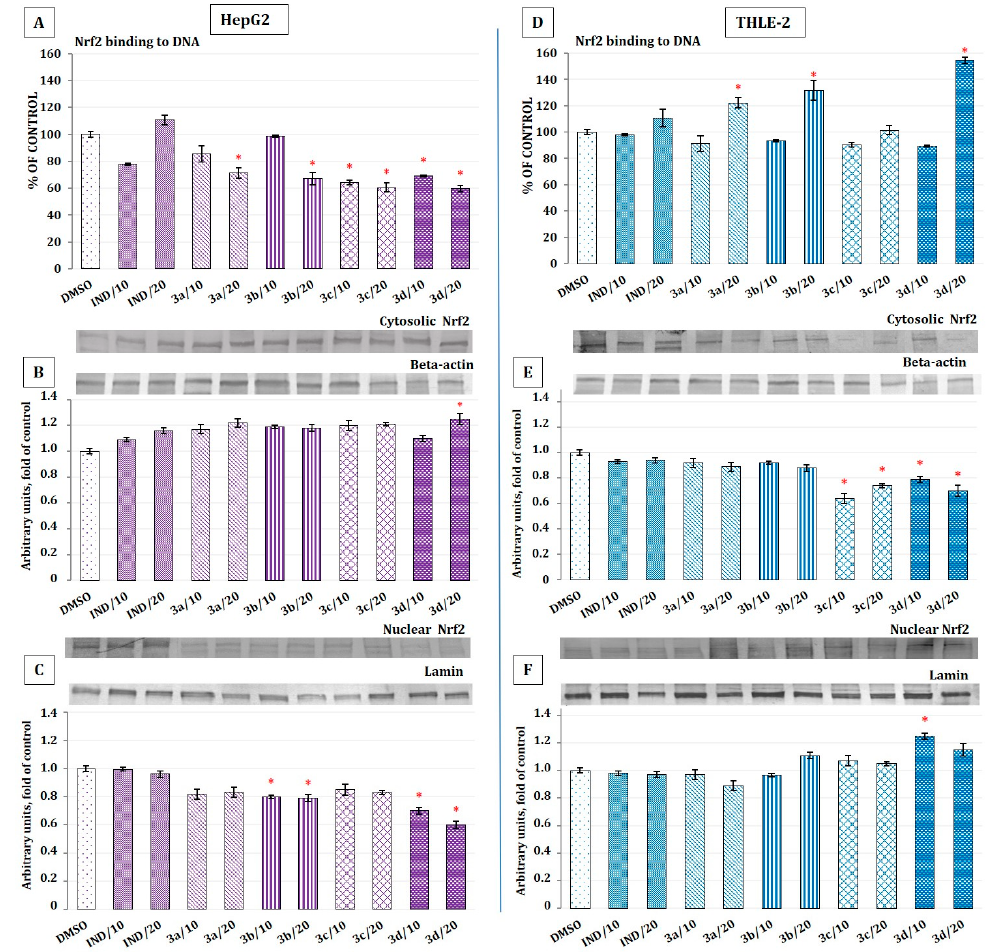
Figure 2. The effect of IND and OAO–IND derivatives ( 3a, 3b, 3c, and 3d ) on the Nrf2–DNA binding capability and translocation from cytosol to nuclei in HepG2 ( panels A – C ) and THLE-2 ( panels D – F ) cells. Activated Nrf2 was as- sessed in terms of the amount of Nrf2 contained in the DNA-binding complexes extracted from the nuclear fraction ( panels A,D ). Data (means ± SEM) from three separate experiments are presented (expression equals 100%). Representa- tive immunoblots for the analysis of the cytosolic ( panels B,E ) and nuclear ( panels C,F ) levels of Nrf2 protein are shown. The sequence of the bands corresponds to the sequence of the bars in the graph. Lamin and β -actin content were used for the normalization of the results. The values were calculated as protein level in comparison with control cells (expression equals 1). * Significantly different from DMSO (control)-treated cells, p < 0.05.